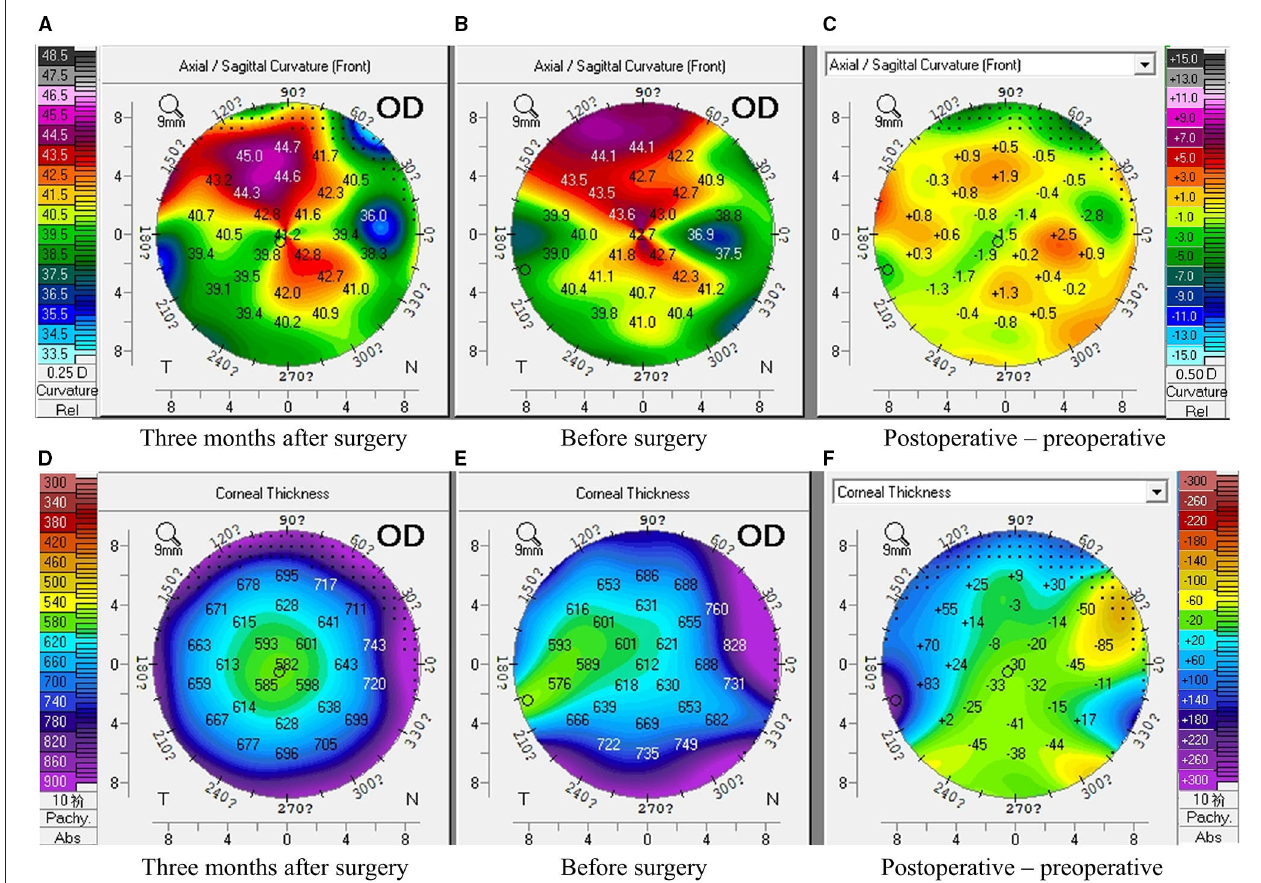
FIGURE 2 | Corneal topography of band keratopathy following treatment of retinoblastoma before and three months after surgery. (A–C) The corneal curvature remained stable pre and post-operation ( A : three months after surgery, B : before surgery, C : the difference between a and B ); (D,E) The corneal thickness decreased after the surgery ( D : three months after surgery, E : before surgery, F : the difference between D and E